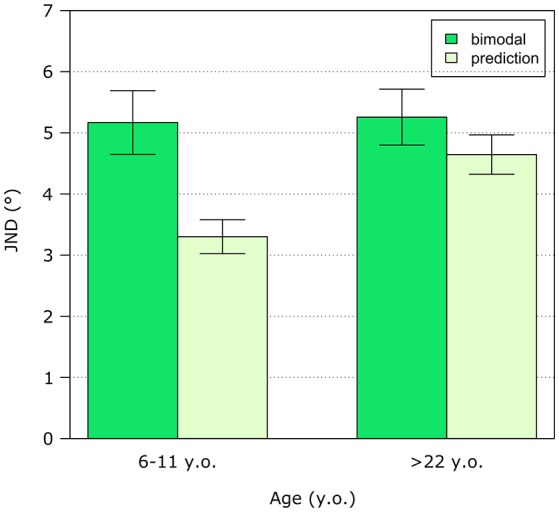
Bimodal vs. predicted variability. Variability is represented as the mean JND across subjects divided into two groups: children of primary school age (6–11 y.o.) and adults (>22 y.o.). Error bars show standard error.